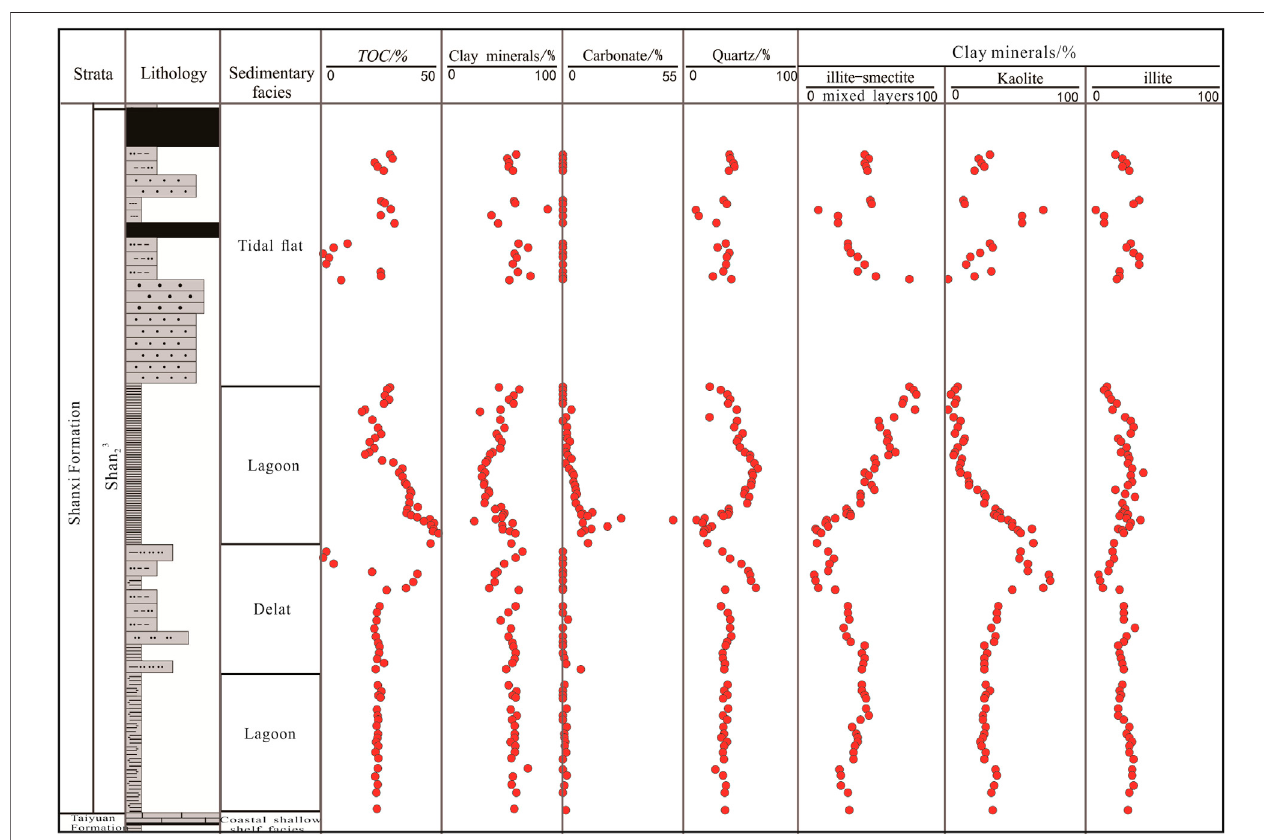
FIGURE 2 | TOC content and mineral compositions of the shale reservoir in the Shan 23 sub-member of Well DJ 3 – 4. (TOC, clay minerals, carbonate and quartz data from Zhang et al., 2021)